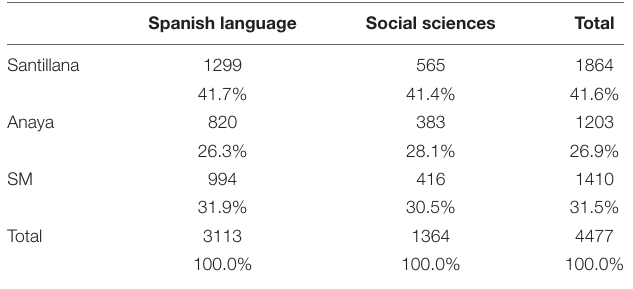
TABLE 1 | Distribution of activities by subject and